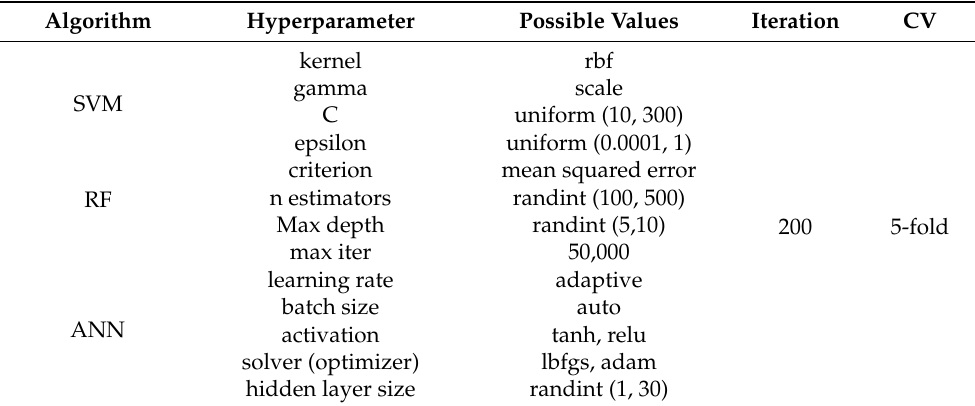
Table 3. Hyperparameter settings for SVM, RF, and ANN algorithms,